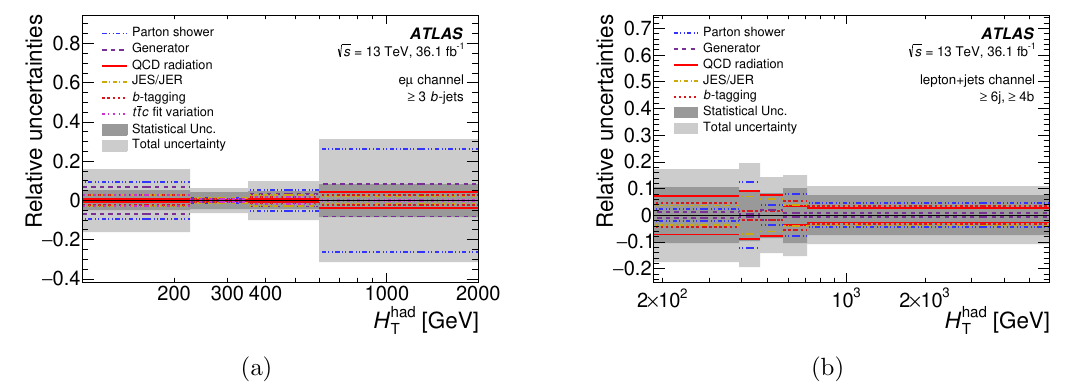
Figure 11. Relative systematic uncertainties from various theoretical and experimental sources for H had variable measured in the (a) e(cid:22) and (b) lepton + jets channels. T